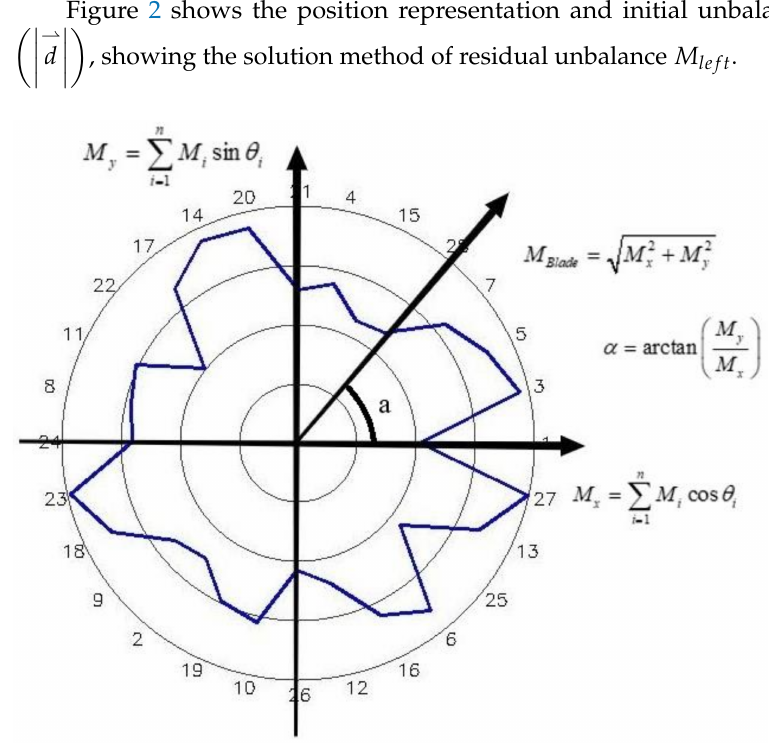
Figure 2. Remaining unbalance of